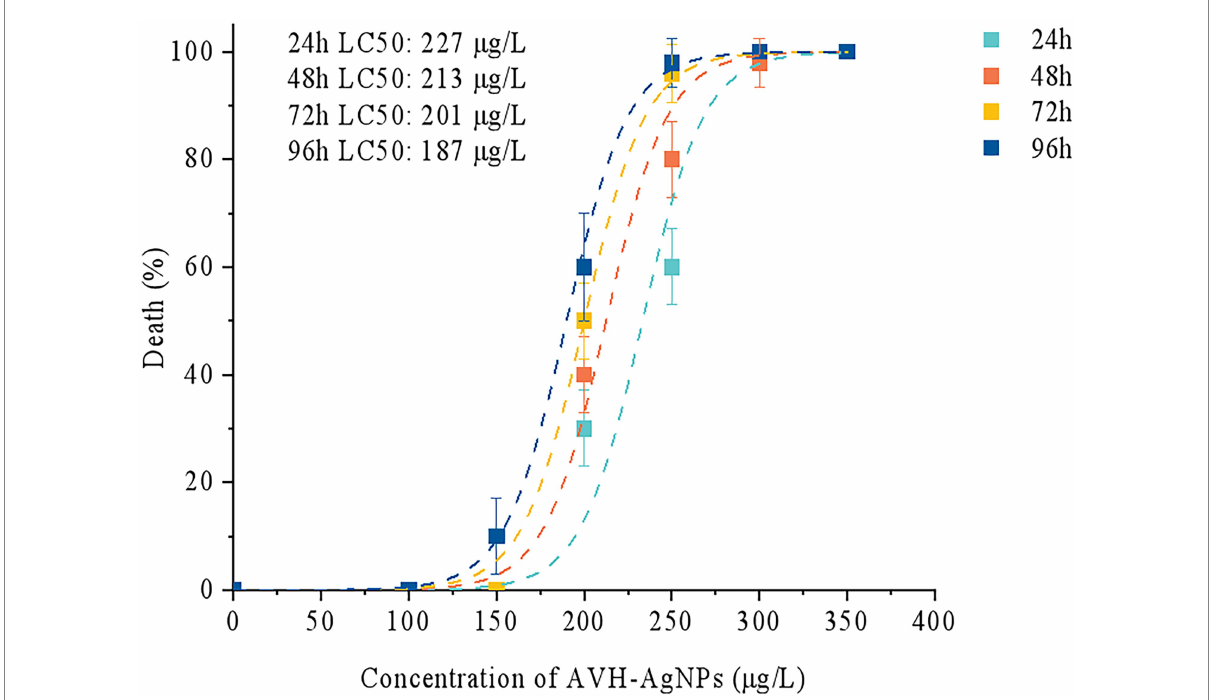
FIGURE 2 Median lethal concentration (LC50) of AVH-AgNPs on zebrafish, the LC50 values of AVH-AgNPs against zebrafish at 24, 48, 72, and 96 h were 227, 213, 201, and 187 μ g/l,